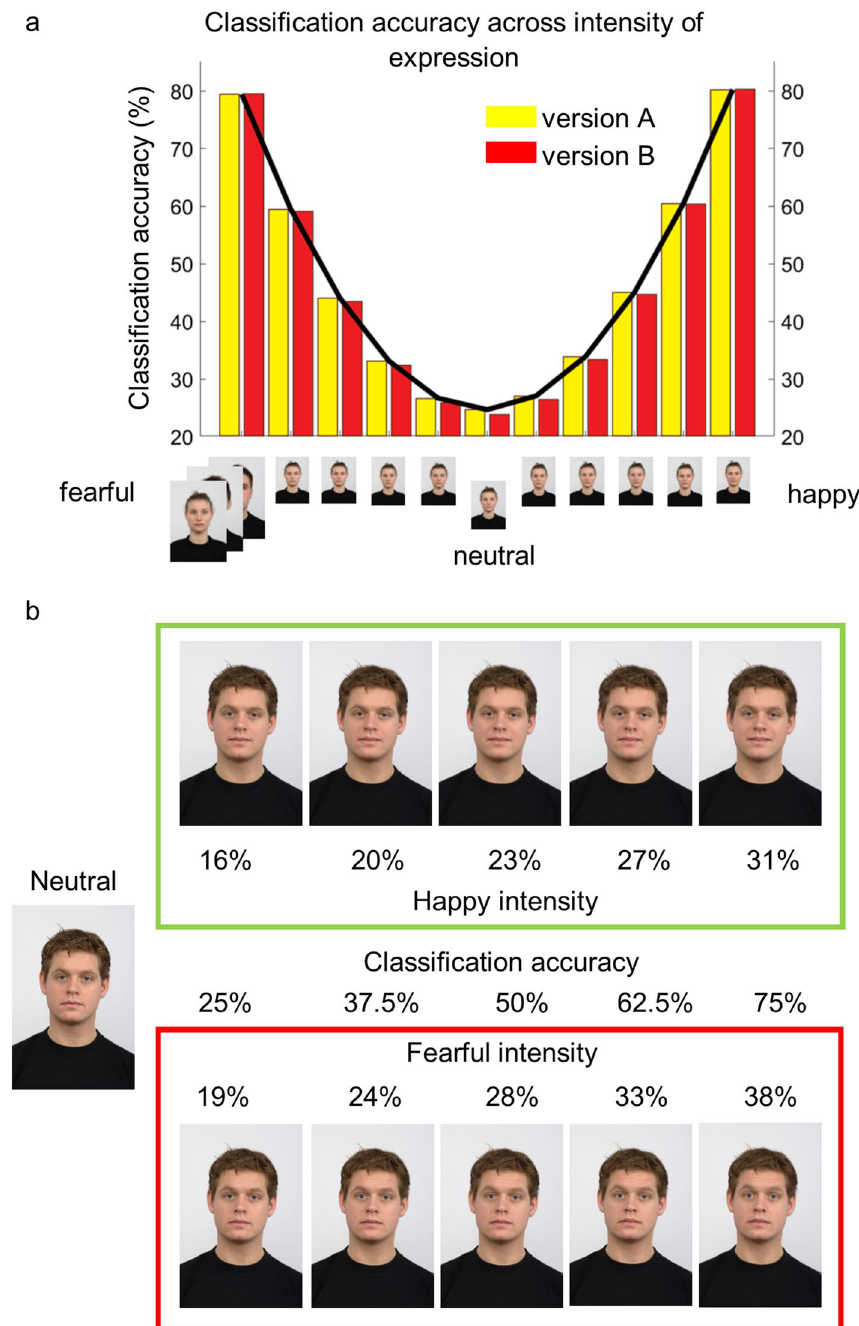
Figure 4. Matched stimulus sets and example stimuli. ( a ) Mean accuracy ratings of the two parallel stimulus sets as derived from the pilot study. ( b ) Example of stimuli used. Five steps of expression intensity for happy and fearful emotions and a neutral expression were used for each identity. Values presented in the colored boxes indicate the approximate expression intensity on the morphing dimension from 0% (neutral) to 100% (happy/ fearful). Faces depicted are used with permission from the Radboud Face